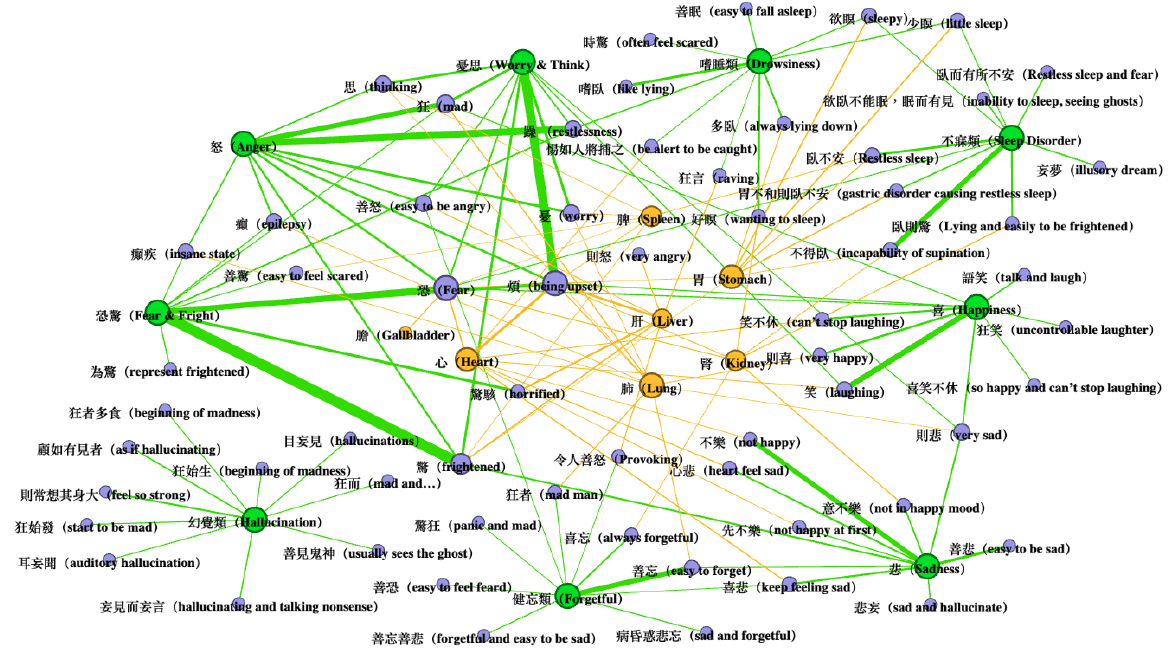
Figure 1. Overview of mental disorder network of Huangdi Neijing.